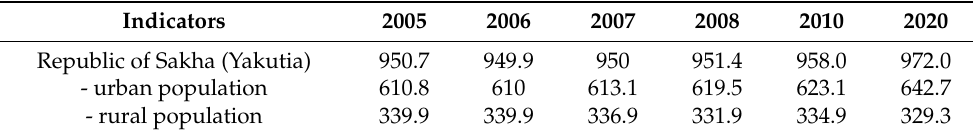
Table 2. Population at beginning of the year, thousand people.